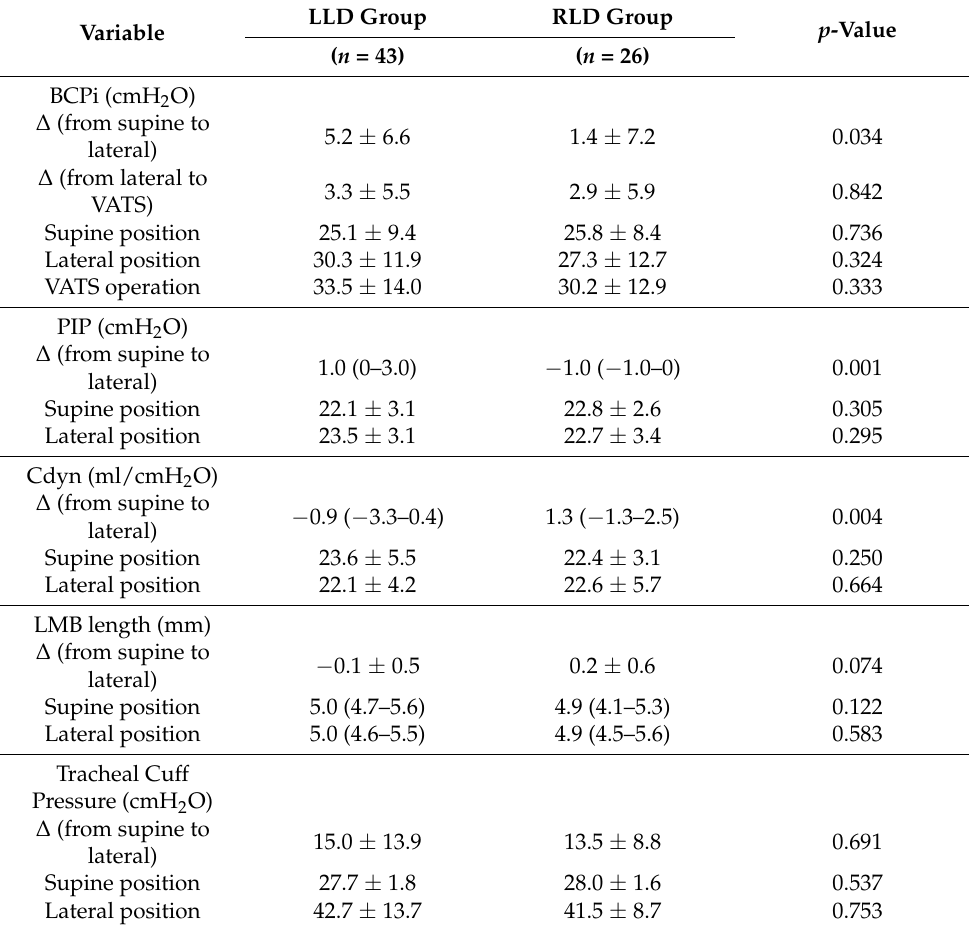
Table 2. Characteristics of patients, anesthesia and